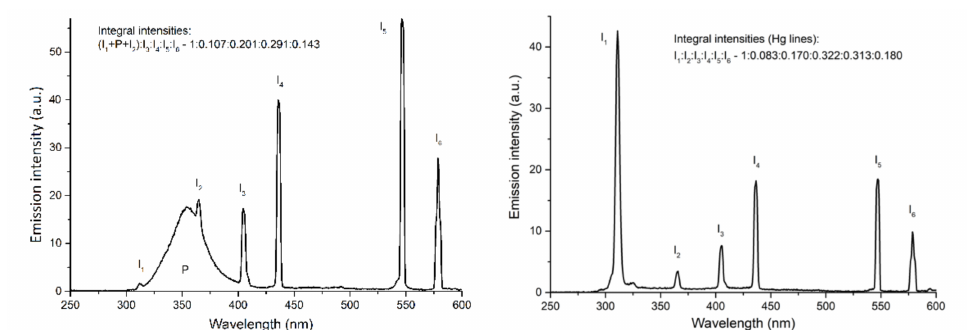
Figure A1. UVA ( left ) and UVB ( right ) radiation spectra of used sources.